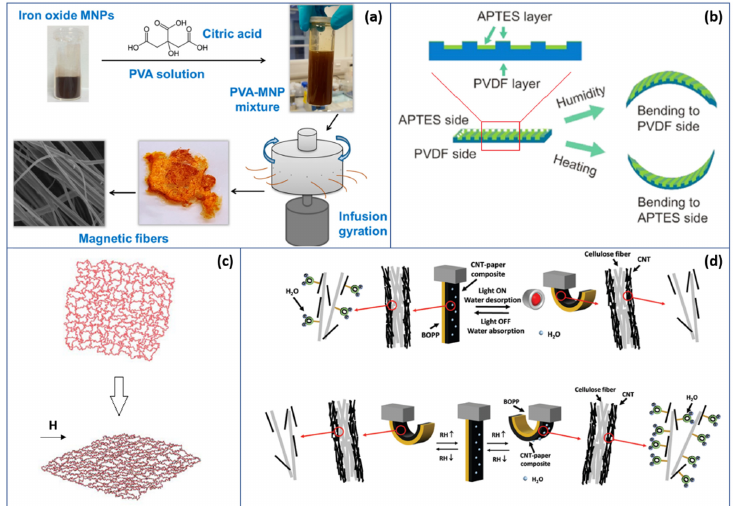
Figure 5. Polymers responding to various stimuli: ( a ) magnetic fiber for controlled drug delivery [106]; ( b ) multiresponsive kinematics and robotics in polymer films with a designed shape-programmable surface pattern (Reprinted with permis- sion from Liang, S.; Qiu, X.; Yuan, J.; Huang, W.; Du, X.; Zhang, L. Multiresponsive Kinematics and Robotics of Surface- Patterned Polymer Film. ACS Appl. Mater. Interfaces 2018 , 10 (22), 19123–19132. Copyright American Chemical Society) [110]; ( c ) comparison of chain behavior in magnetic gel before (top) and after (bottom) a magnetic field is applied [105]; ( d ) humidity and light-driven actuating mechanisms of CNT-paper/BOPP composites [111].